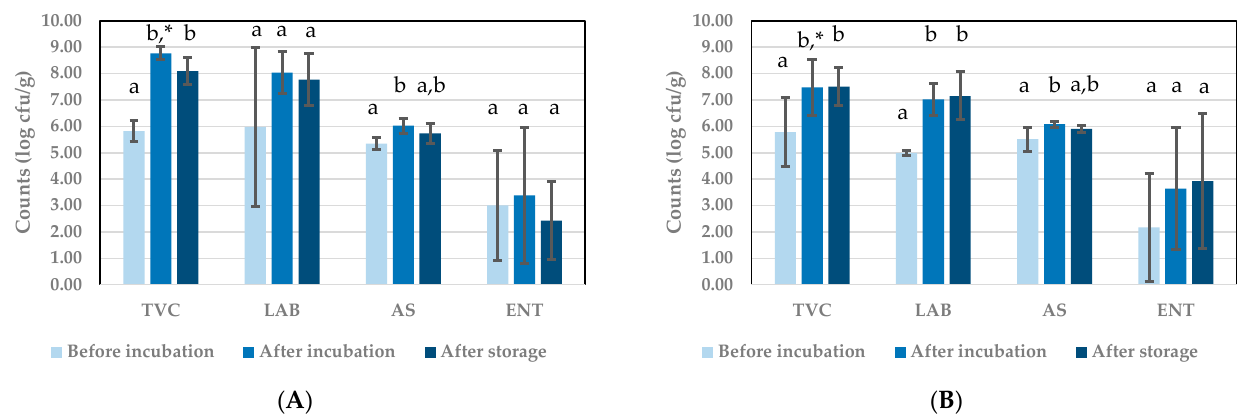
Figure 4. Microbial counts during experiments to investigate the potential of starter Lactobacillus farciminis : ( A ) replicates incubated without starter (control); ( B ) replicates incubated with starter. Results are the mean of three replicates ( n = 3). TVC: total viable counts; LAB: lactic acid bacteria counts; AS: aerobic endospore counts; ENT: Enterobacteriaceae counts. a,b Means per microbial count with the same superscript do not differ significantly. * Corresponding means indicated with asterisks are significantly different.